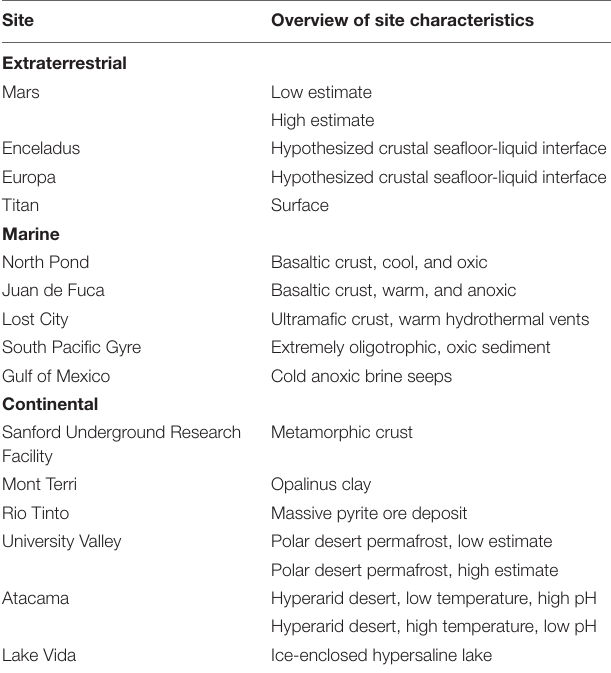
TABLE 1 | Extraterrestrial and Earth low energy subsurface analog sites considered in energy calculations.